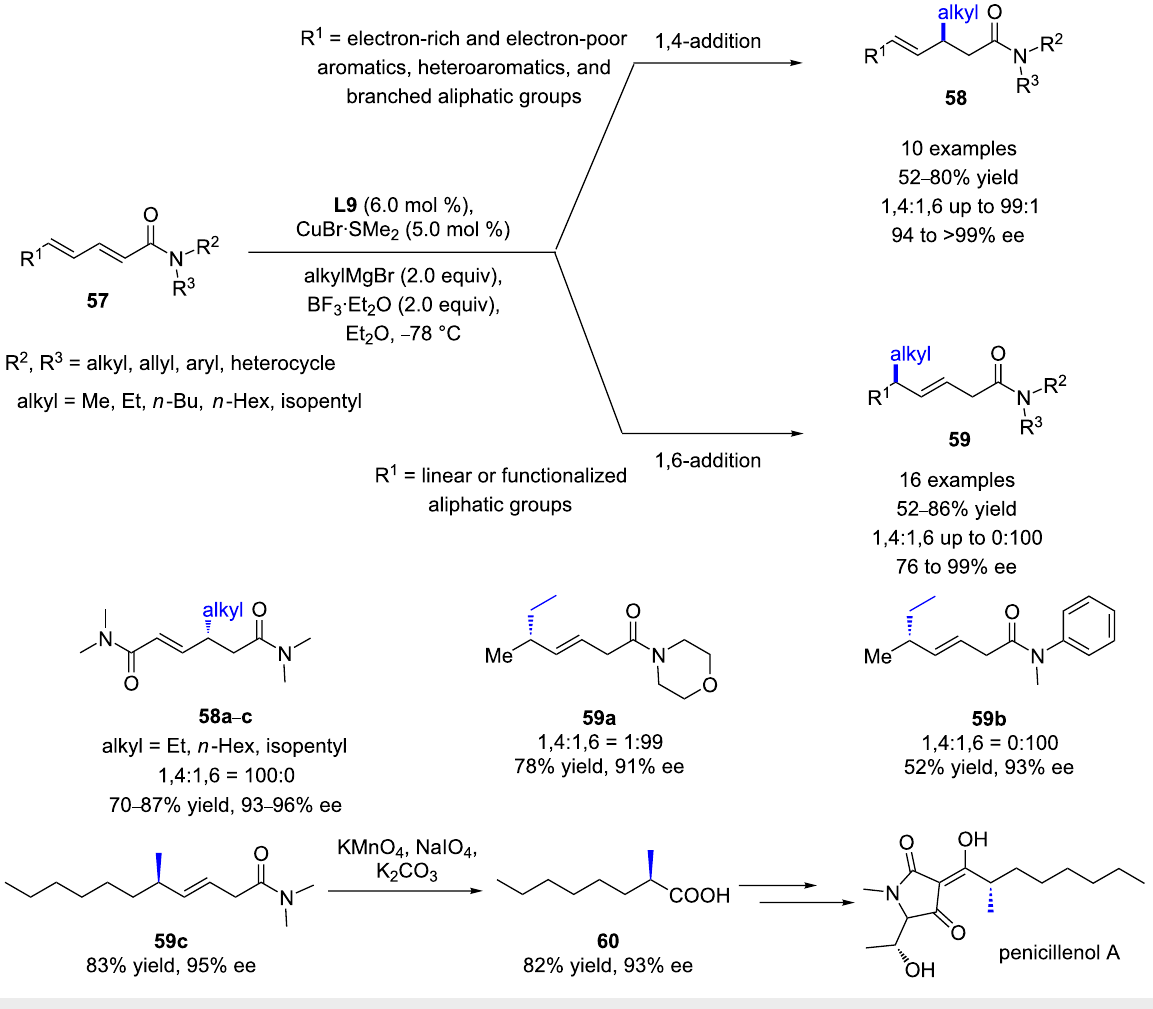
Scheme 22: Cu/Josiphos ( L9 )-catalyzed ECA of Grignard reagents to polyunsaturated